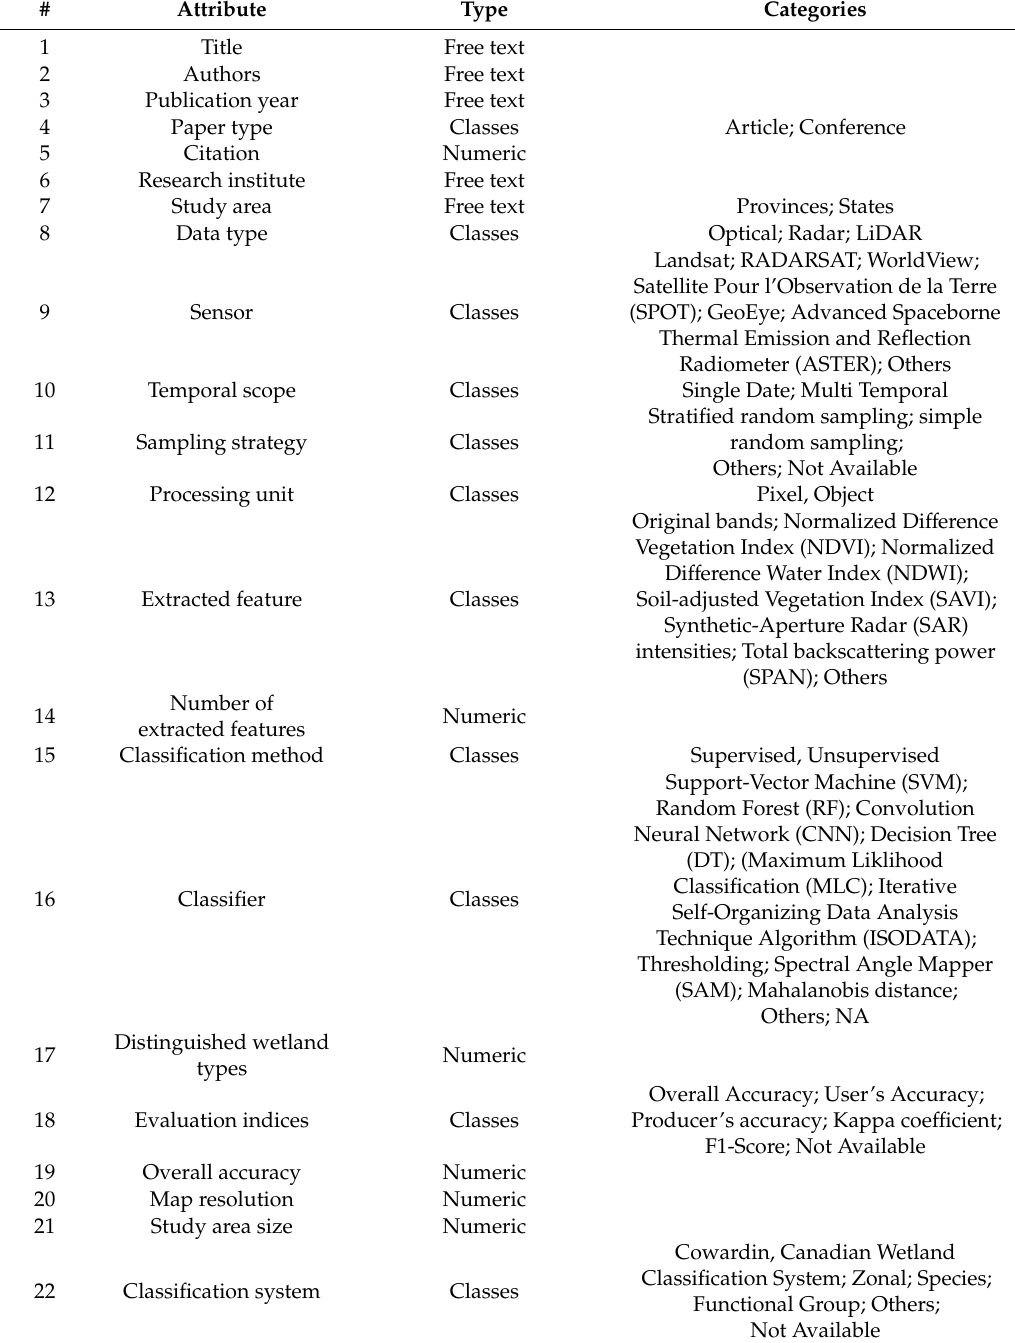
Table 2. Twenty-two attributes used for the meta-analysis database of wetland mapping in North